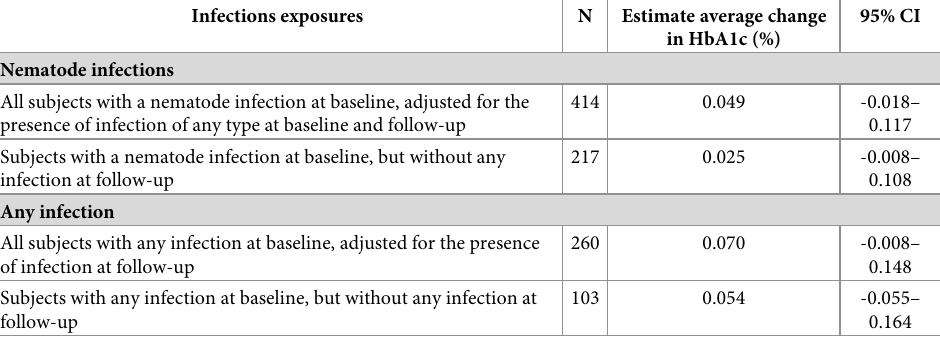
Table 4. Adjusted 1 estimate of average change in HbA1c (follow-up minus baseline) among children infected at baseline and visiting schools without lifestyle intervention. Infections